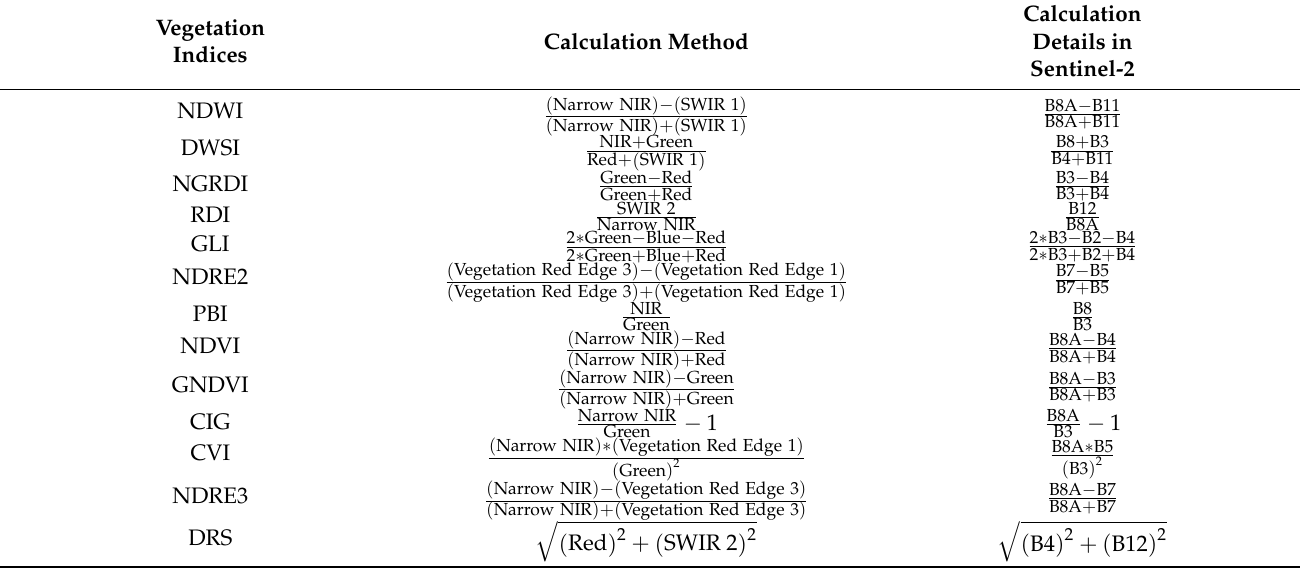
Table 2. Method for calculating vegetation